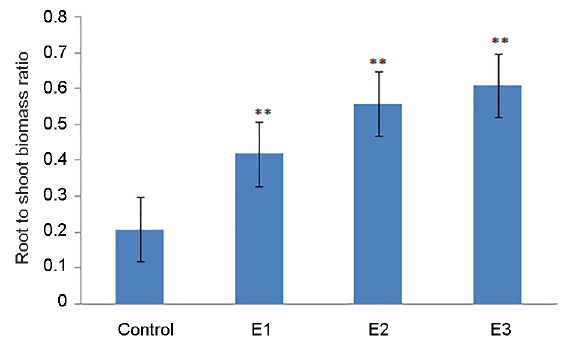
Figure 1. Comparison of changes in root to shoot biomass ratio in the experimental